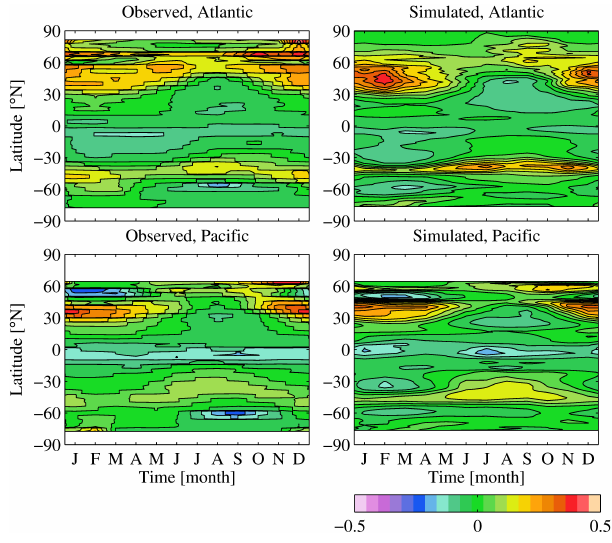
Fig. 21. Observational (Takahashi et al., 2009; left ) and simulated ( right ) air–sea CO 2 flux for northern summer (June–July–August; top ) and northern winter (December–January–February; bottom ). Air–sea CO 2 flux in mol C m − 2 month − 1 .